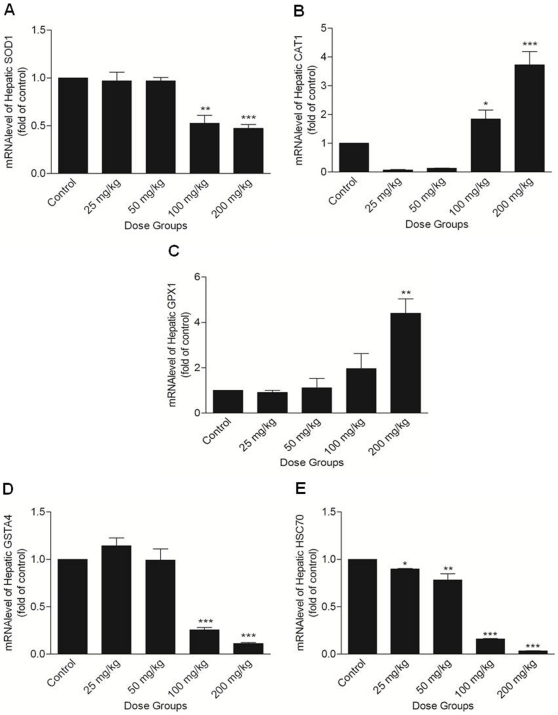
Quantitative real time PCR analysis of stress regulated genes.(A) SOD1, (B) CAT, (C) GPx1, (D) GSTA4, and (E) Hsc70 mRNA levels in the liver of mice treated with different doses of Apigenin (Control, 25, 50, 100 and 200 mg/kg). The asterisks indicate significance of differences (*-p<0.05; **-p<0.01; ***-p<0.001) in comparison to control.